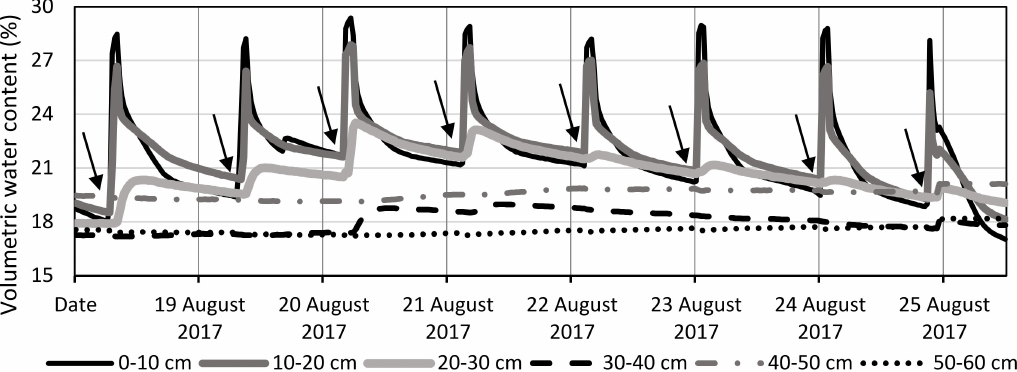
Figure 2. Pattern of soil volumetric water content during the period of 18 to 25 August for ‘Orogrande’ Cntl treatment according to soil depth. Arrows indicate irrigation